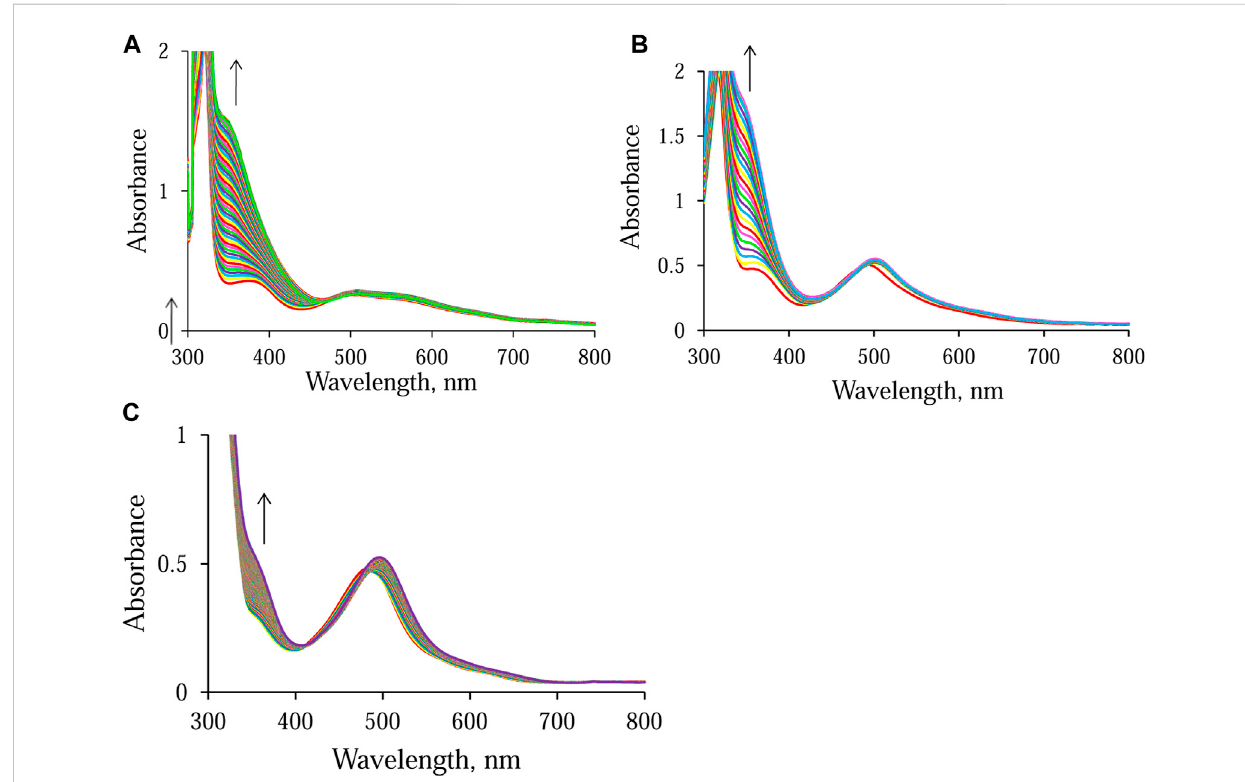
FIGURE 4 Spectral changes observed during the reduction of NAD + to 1,4-NADH in the presence of formate in water/ethanol (1:9, v/v) solution catalyzed by [Ru II (terpy)(N ∧ N)(H 2 O/EtOH)] 2+ monitored at 340 nm. Experimental conditions: (A) N ∧ N = en, [HCOO − ] = 14.5 mM; (B) N ∧ N = ampy, [HCOO − ] = 58 mM; (C) N ∧ N = bipy, [HCOO − ] = 58 mM; [Ru] = 0.053 mM [NAD + ] = 0.31 mM, T = 36.8 ° C; spectra recorded every (A) 15 min, (B) 60 min, and (C) 15